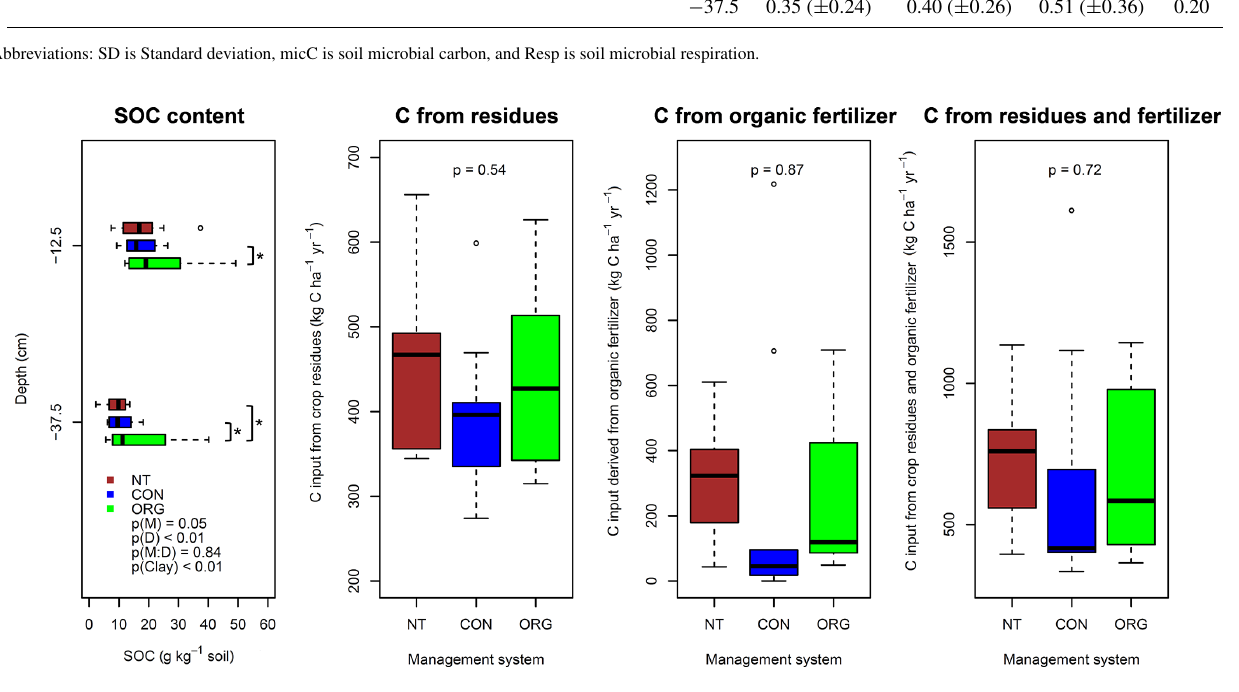
Figure 3. Effects of soil management ( M ), sampling depth ( D ), their interaction ( M : D ), and clay content (Clay) on soil organic carbon content, analysed with linear mixed models (Eq. 2) followed by analysis of covariance ( n = 10), and effects of management on exogenous carbon inputs calculated as described in Büchi et al. (2019) using analysis of variance (NT is n = 10, CON is n = 9, and ORG is n = 10). NT (red), CON (blue), and ORG (green) denote no-till, conventional, and organic management system, respectively. ∗ indicates significant difference between management systems at individual depths using least significant difference (LSD) tests at p< 0 .